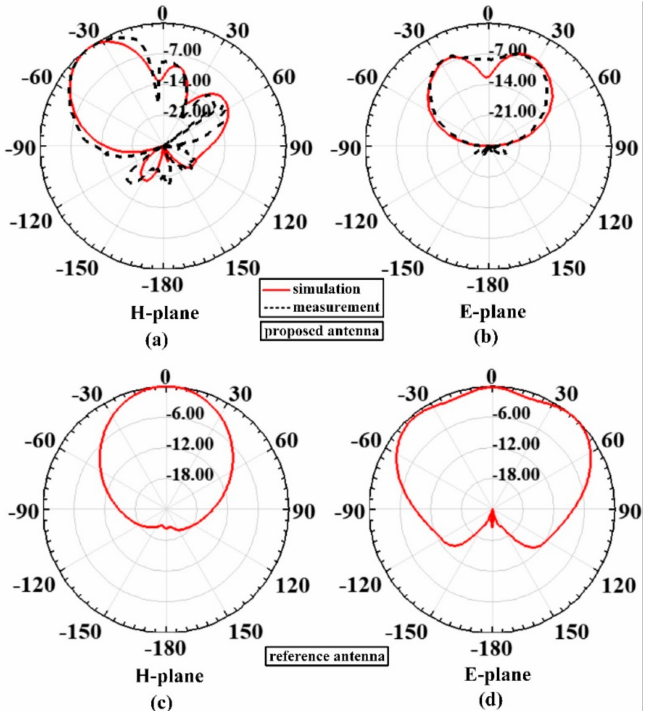
Figure 6. Radiation patterns of the proposed antenna, ( a ) H-plane. ( b ) E-plane. Radiation patterns of the reference antenna, ( c ) H-plane. ( d )